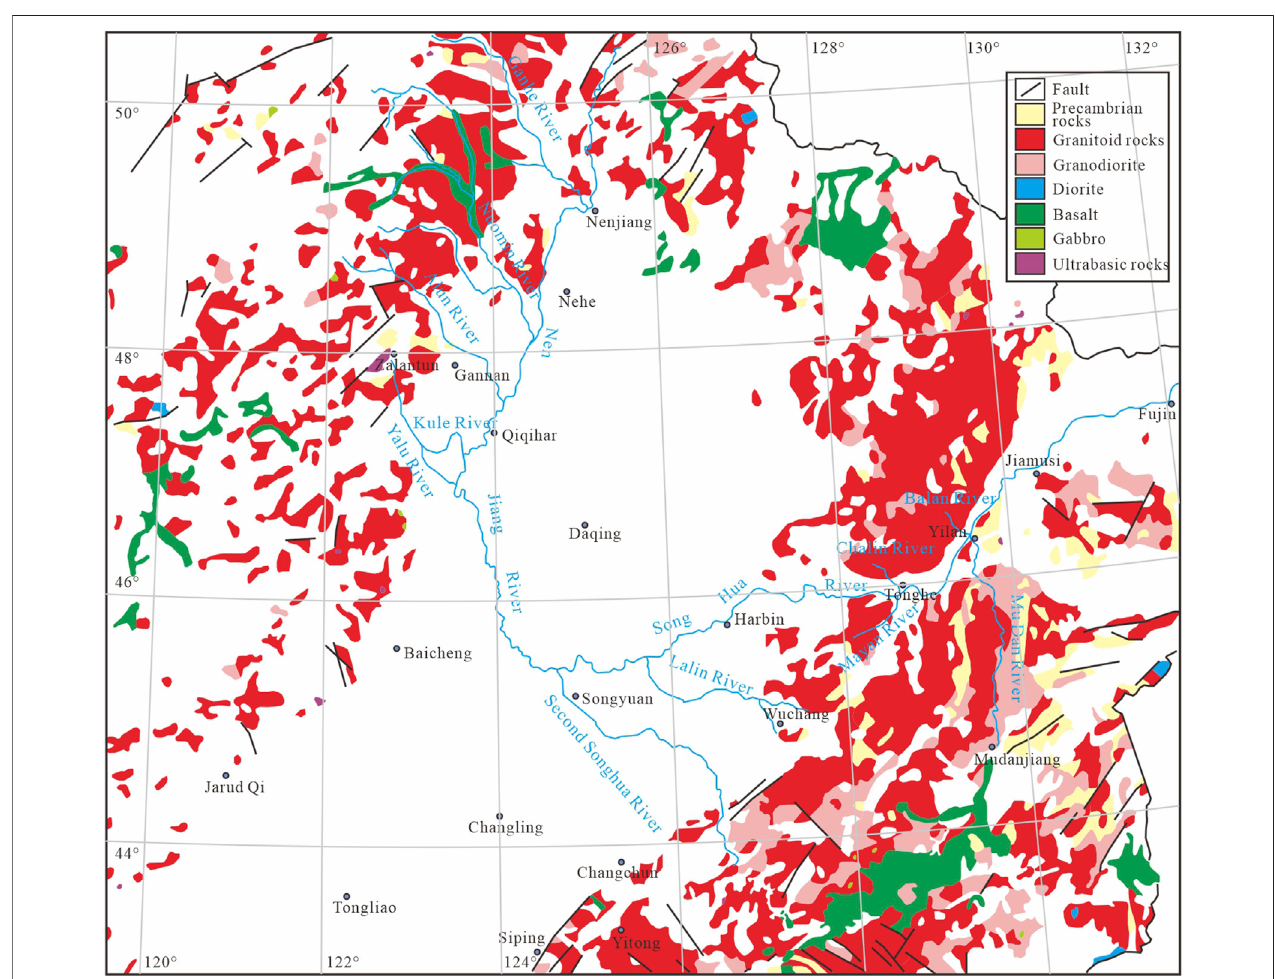
FIGURE 2 | Simpli fi ed geological map of the Songnen Plain (modi fi ed from Fu et al., 2019), where granitoid rocks are dominant, especially in the eastern Songnen Plaininwhichgranitoidrocksappearroutinelyasamassiveintrusion.NotethatbasaltrocksappeardominantlyintheGreatHingganMtsandtheChangbaiMts,andthat ultrabasic rocks only appear in the Zalantun located on the east side of the Great Hinggan Mts. (For interpretation of the references to colour in this fi gure legend, the reader is referred to the web version of this article.)